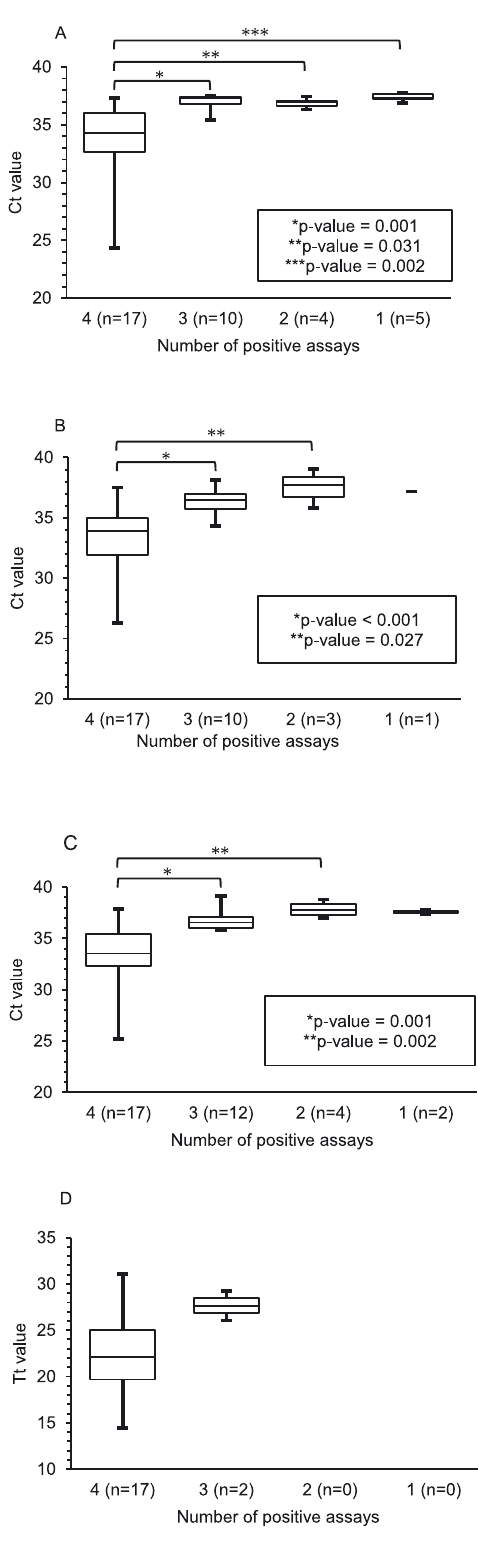
Figure 2: Relationship between the number of SARS-CoV-2 detec- tion assays that have positive results and the cycle threshold (Ct) or threshold time (Tt) values. (A), (B), (C), and (D) depict the SHIMADZU assay N1, NIID assay N2, Roche assay E, and Eiken assay N + RdRp, respectively. The p-value was calculated using the Mann – Whitney U